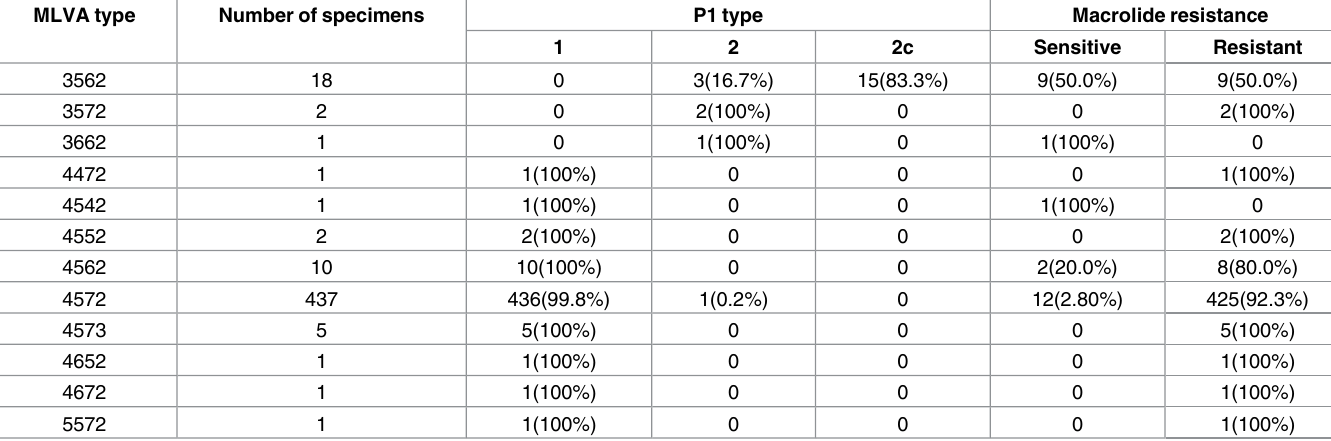
Table 2. Relationship between MLVA type, P1 type, and macrolide resistance between 2003 and 2015. MLVA